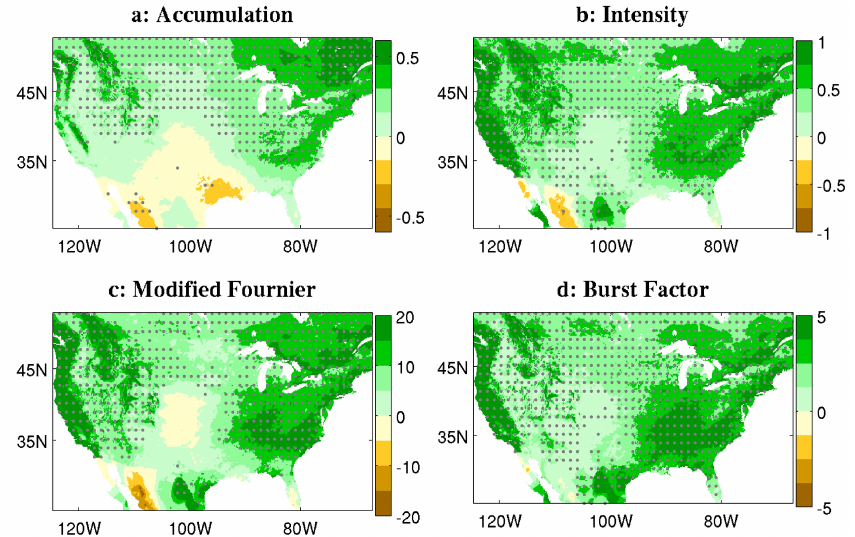
Figure 10. Projections of changes in rainfall characteristics: difference between 2079–2099 and 1980–2000, where the future period is simulated under the RCP8.5 scenario and the past is from the historical simulation. Shown are ensemble mean differences, with stippling indicating that more than two-thirds of the models agree on the sign of the change (stippling is plotted at coarser spatial resolution, for clarity). (a) Annual mean rainfall accumulation. (b) Rainfall mean daily intensity. (c) Modified Fournier index. (d) Burst